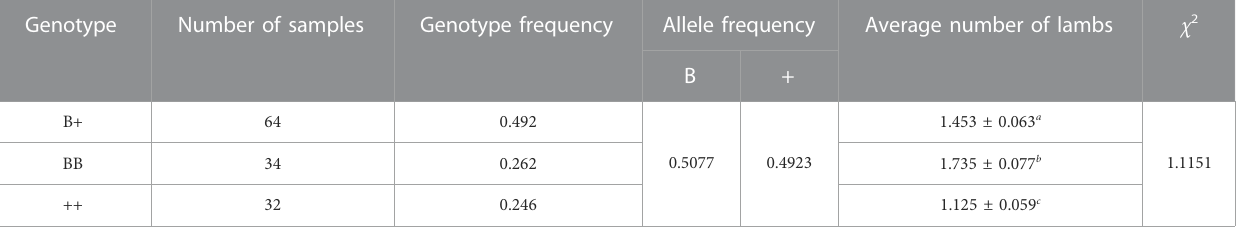
TABLE 3 The genotype frequency and litter size of different BMPR1B genotypes of Pishan Red sheep.